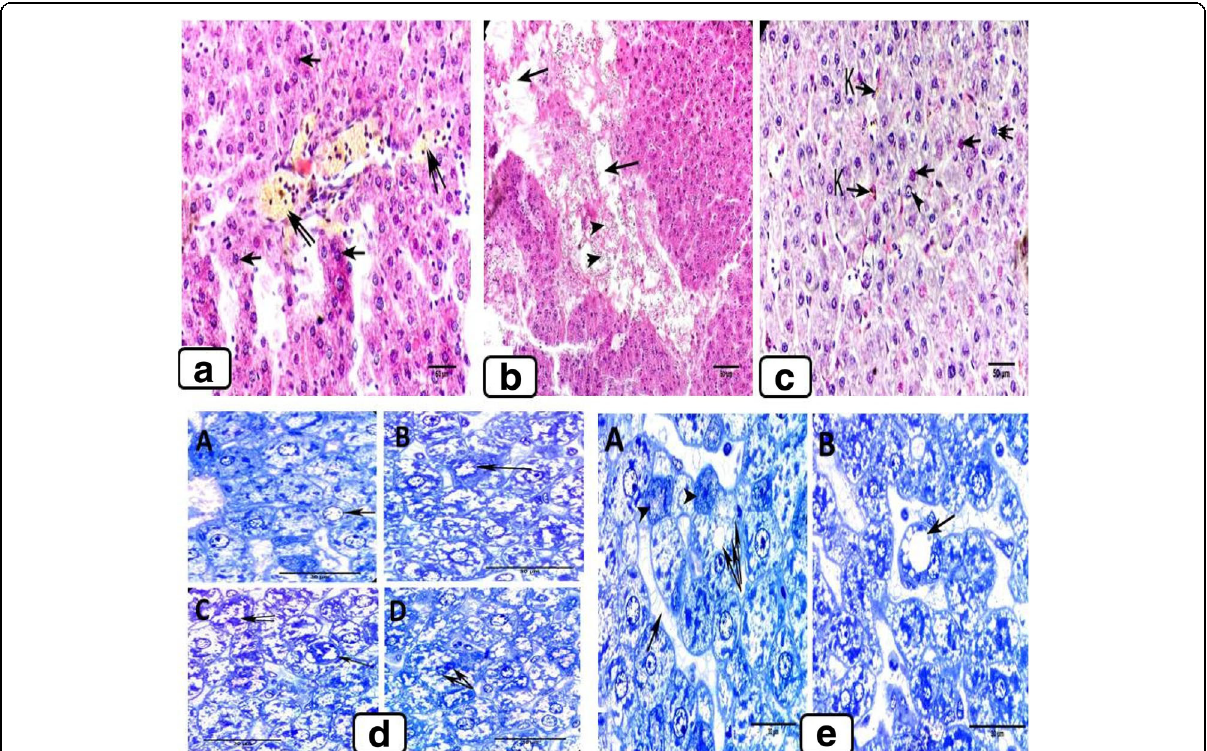
Fig. 5 M3 group liver showing a many necrotic areas (n), bilirubin filled the blood sinusoid and between hepatocytes ( ↑↑ ), degeneration of most of the hepatocytes and small dark stain nuclei was observed ( ↑ ) (H&E). b Marked extensive necrosis of large area of hepatocytes with dispersion of their contents and areas devoid of hepatocytes ( ↑ ). Note: RBCs in the destructed area (hemorrhage) (arrowhead) (H&E). c Polyploid nuclei (red and blue color) ( ↑ ), chromatin of few nuclei segregation in their inner membrane and appeared empty (arrowhead) and other hepatocytes with small dark stained nuclei ( ↑↑ ). Notice lipofuscin pigments (yellow-brown color) in few Kupffer cells (K) (H&E). d A nuclei showed chromatolysis, B Irregular shape of nuclei, C nuclei enlarged in size with clumped of their chromatin and D hypertrophic of binucleated hepatocytes with pyknotic nuclei (toluidine blue stain). e A Hepatocyte with many of vacuoles differed in size ( ↑↑ ), apoptotic cells (arrowhead), and dilated and congested blood sinusoids with a thickened wall ( ↑ ). B Hepatocyte contains large vacuole (toluidine blue